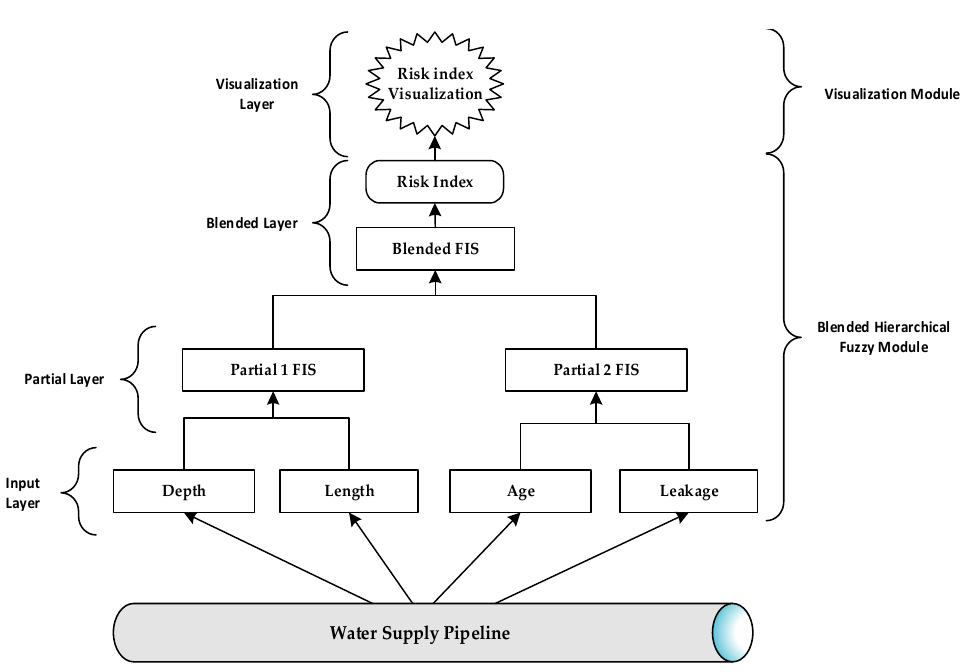
Figure 1. Proposed water supply pipeline risk assessment and visualization model.